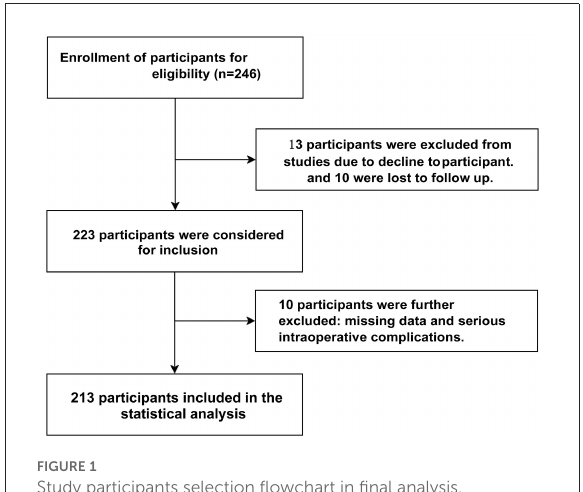
FIGURE1 Study participants selection flowchart in final